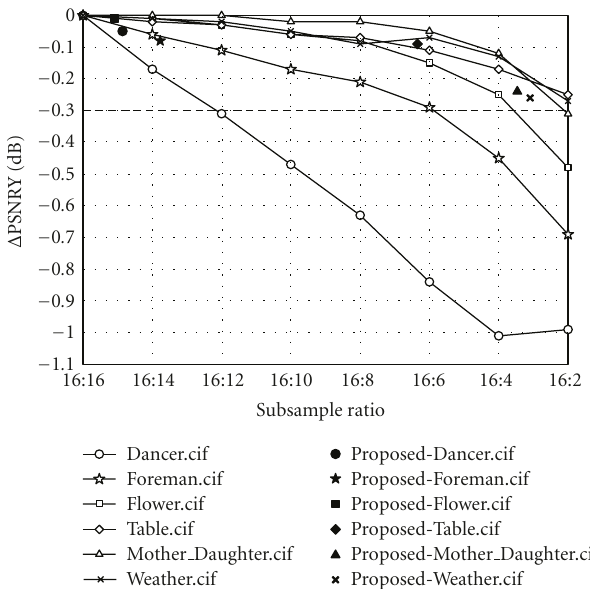
Figure 10: The quality degradation chart of FME with fixed subsample ratios and proposed algorithm.